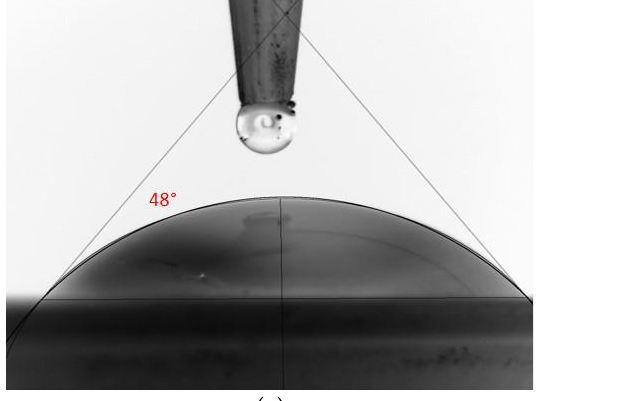
Figure 3. ( a ) Water contact angle of the control sample. ( b ) Water contact angle of the 5% ZnO sam- ple.